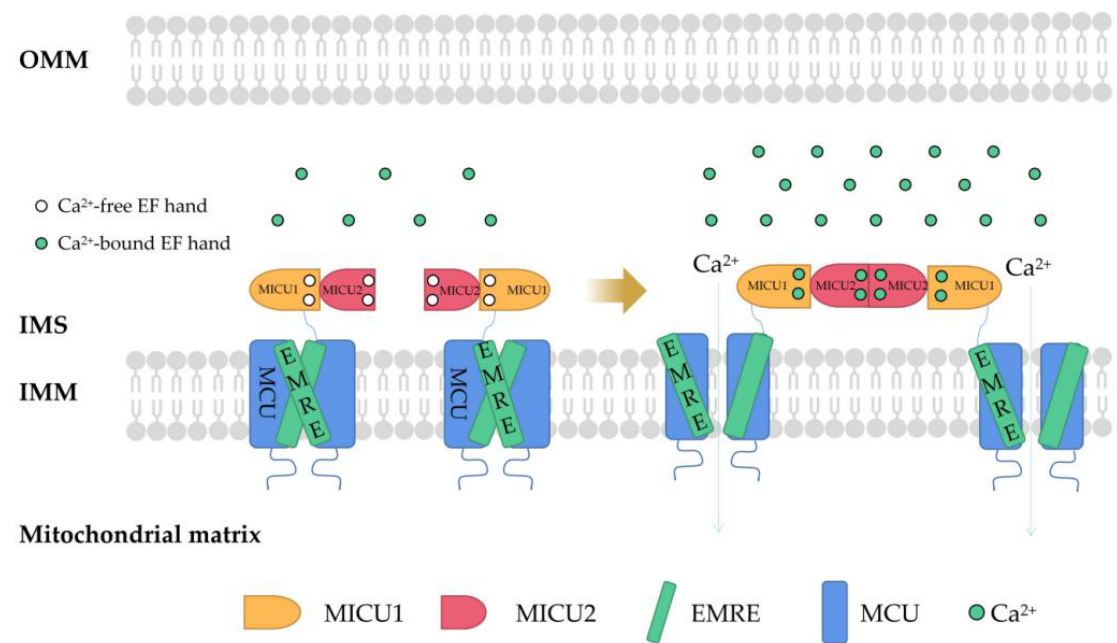
Figure 1. The structure of MCU and connections to its regulators. Mitochondrial Ca 2+ uptake through MCU. In mammals, MCU contains four core components: pore-forming MCU protein, the gatekeepers MICU1 and MICU2, and an auxiliary subunit EMRE. MCU plays a vital role in Ca 2+ transport. In order to prevent Ca 2+ overload, the activity of MCU must be strictly regulated by MICUs, which can sense the change in cytosolic Ca 2+ concentration to open and close the MCU. MCU, mitochondrial calcium uniporter; MICU, mitochondrial Ca 2+ uptake; EMRE, essential MCU regulator; OMM, outer mitochondrial membrane; IMS, intermembrane space; IMM, inner mitochondrial membrane; EF hand, helix−loop−helix structure.